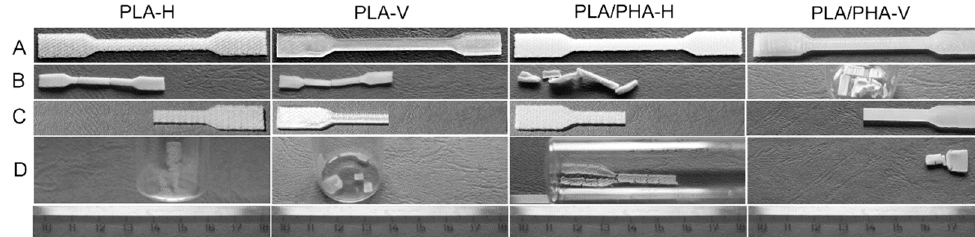
Figure 1. Macrographic images of the polylactide (PLA) and PLA/polyhydroxyalkanoate (PHA) dumbbell-shaped specimens obtained by 3D printing in horizontal (H) and vertical (V) directions before (A and C) and after 70 days of hydrolytic degradation test at 70 °C (B – the whole specimens after degradation, D – cut in half specimens after degradation).